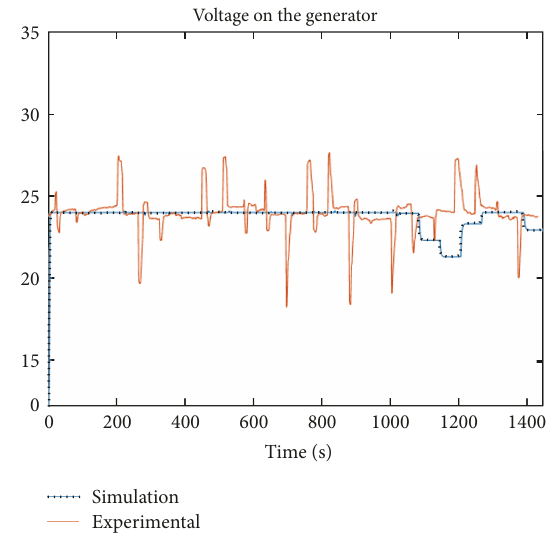
Figure 16: Voltage output for a varying wind speed input with control